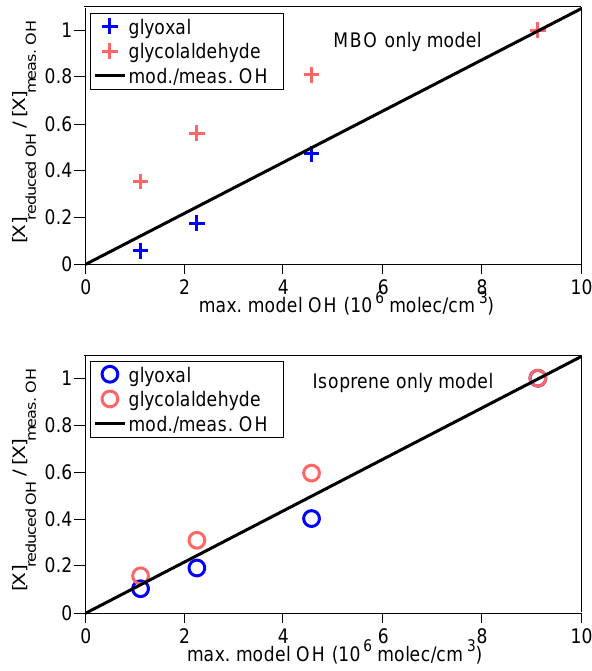
Fig. 5. The fractional reduction in glyoxal and glycolaldehyde con- centration for models using either measured OH or reduced OH during the hot period. The top panel shows results using only MBO chemistry, and demonstrates that glyoxal is correlated to OH concentration while glycolaldehyde (a first generation product of MBO) shows less dependence on OH. In the bottom panel, the re- sults of isoprene oxidiation for the same changes in OH concentra- tion are shown. Here, glyoxal and glycolaldehyde (both of which are mainly higher-generation products of isoprene oxidation) ap- proximately follow changes in OH. The change in glyoxal is slightly more than 1:1 while that of glycolaldehyde is slightly